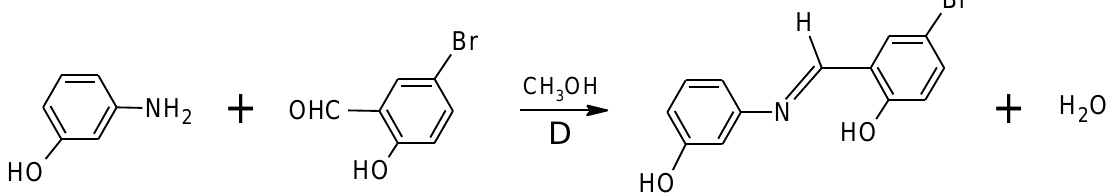
Figure 1. Synthesis scheme of 3-(5-bromo-2-hydroxybenzylideneamino)phenol (BHAP). The product is drawn in the E -enol-imine form (see Section 3, for discussion). Δ